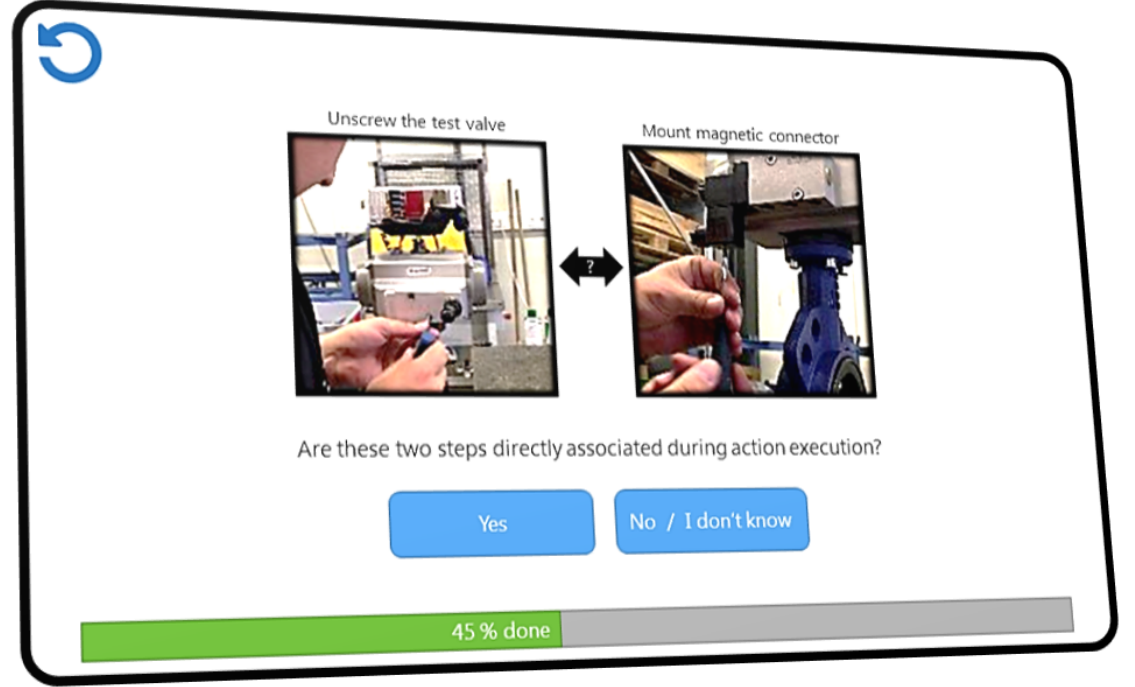
Figure 2. User interface concept of the QSplit structural-dimensional analysis of mental representations (SDA-M) software for gathering a worker’s (unconscious) mental representation structure concerning an assembly